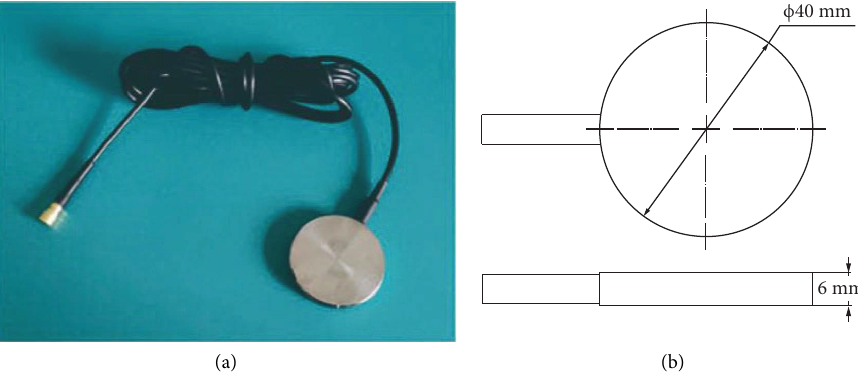
Figure 4: Stress sensor. (a) Physical photo. (b) Specifcations of the sensor.